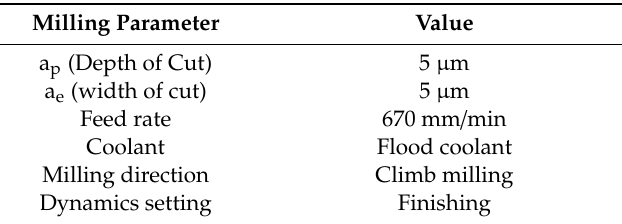
Table 1. Universal milling parameters used in the experiments.